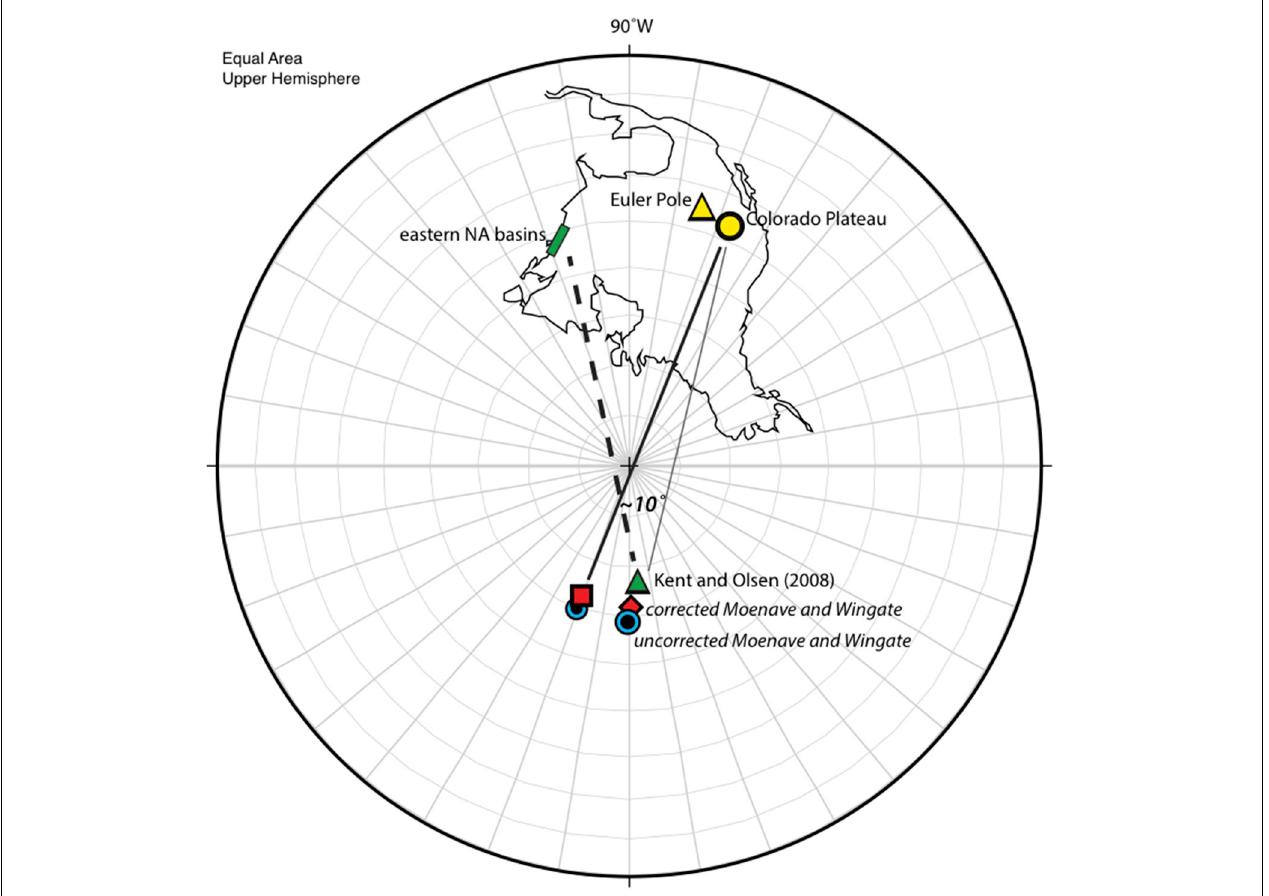
FIGURE 7 | Corrected (red) and uncorrected (blue) paleopoles from the Moenave and Wingate Formations shown in their in situ position (solid black line connects them to the Colorado Plateau locality) and with CP rotation removed (light gray line connects to the Colorado Plateau